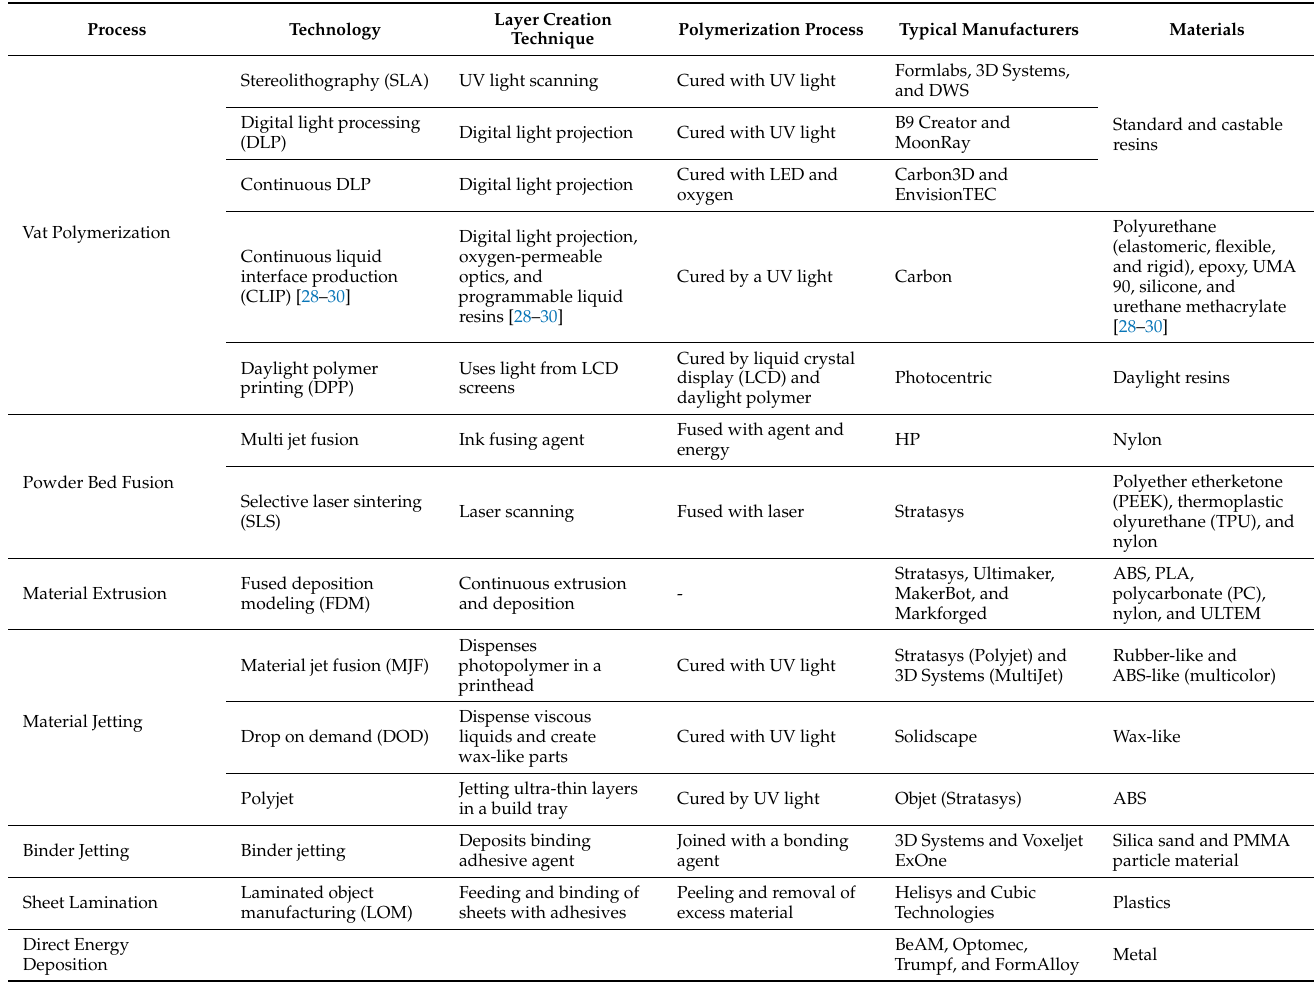
Figure 3. Process flow of the 3D printing process [10]. Reprinted with permission from ref. [10]. Copyright 2021 Elsevier. Table 1. Classification of AM technology according to its process